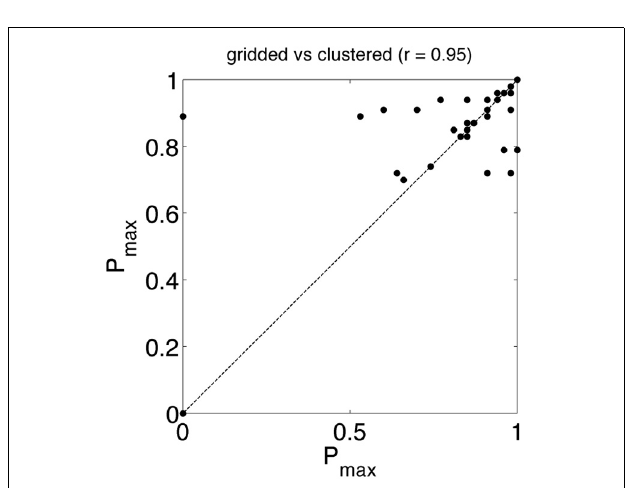
FIGURE 4 | T 50 determined from gridded AOI vs. T 50 determined from clustered AOIs. Each data point represents data from 48 observers in one ad. T 50 represents the time that is required for an AOI to attract fixations from the first unique 50% observers of the population.